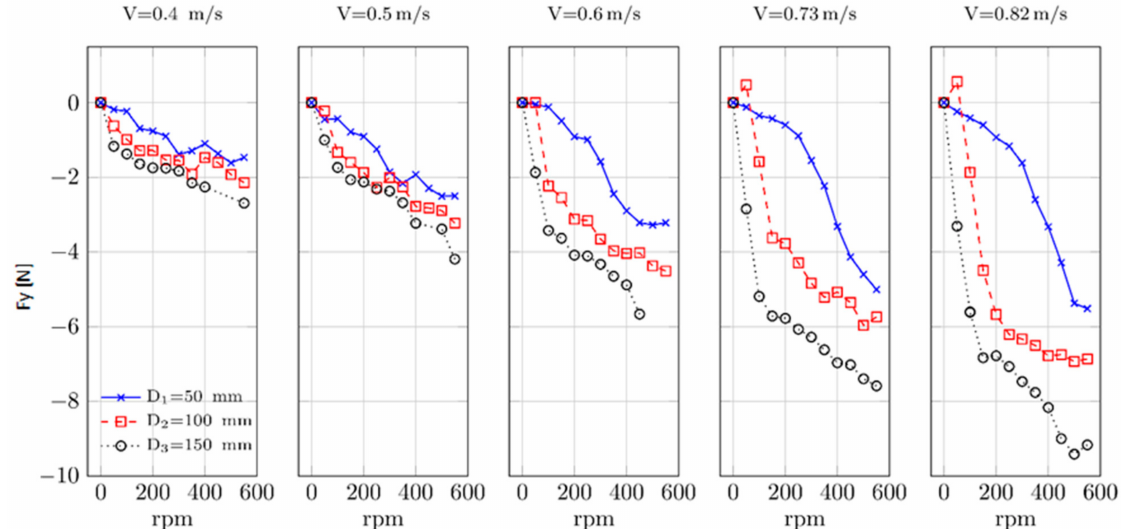
Figure 5. Lift force obtained from the measurements in the wave flume for different flow velocities and cylinder